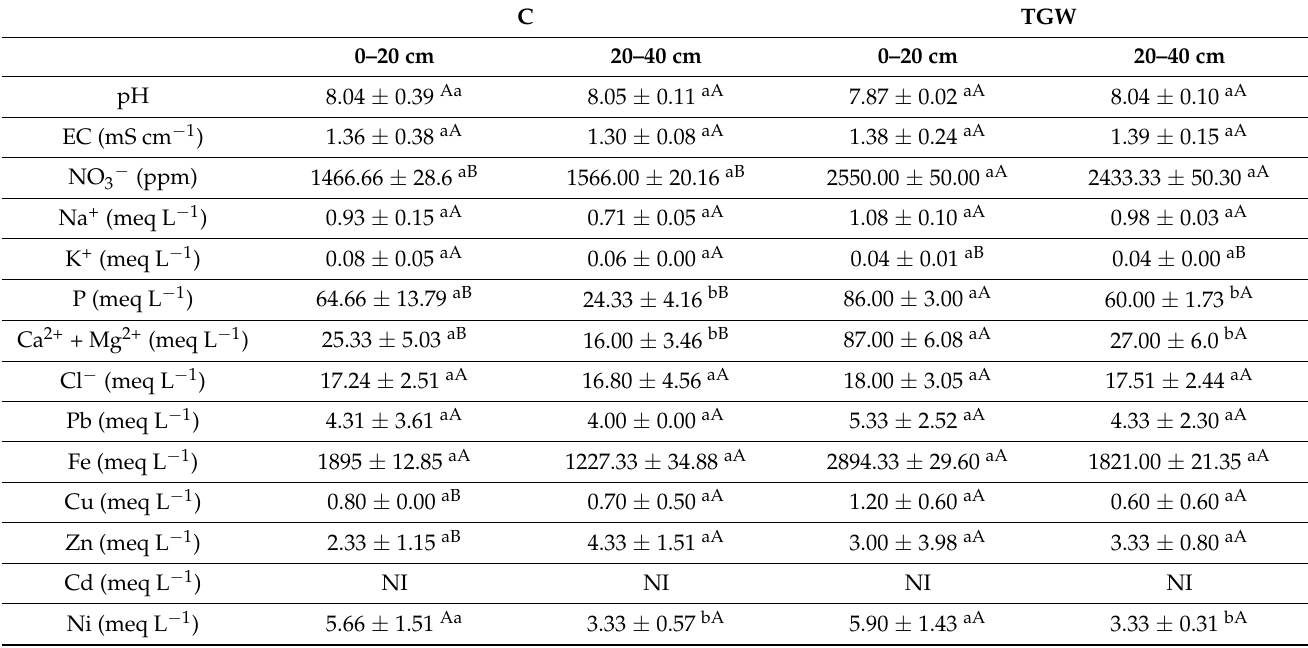
Table 3. Effect of irrigation treatments (C: ground water and TGW: treated grey water) on soil physico-chemical proprieties in the 0–20 cm and 20–40 cm depths.